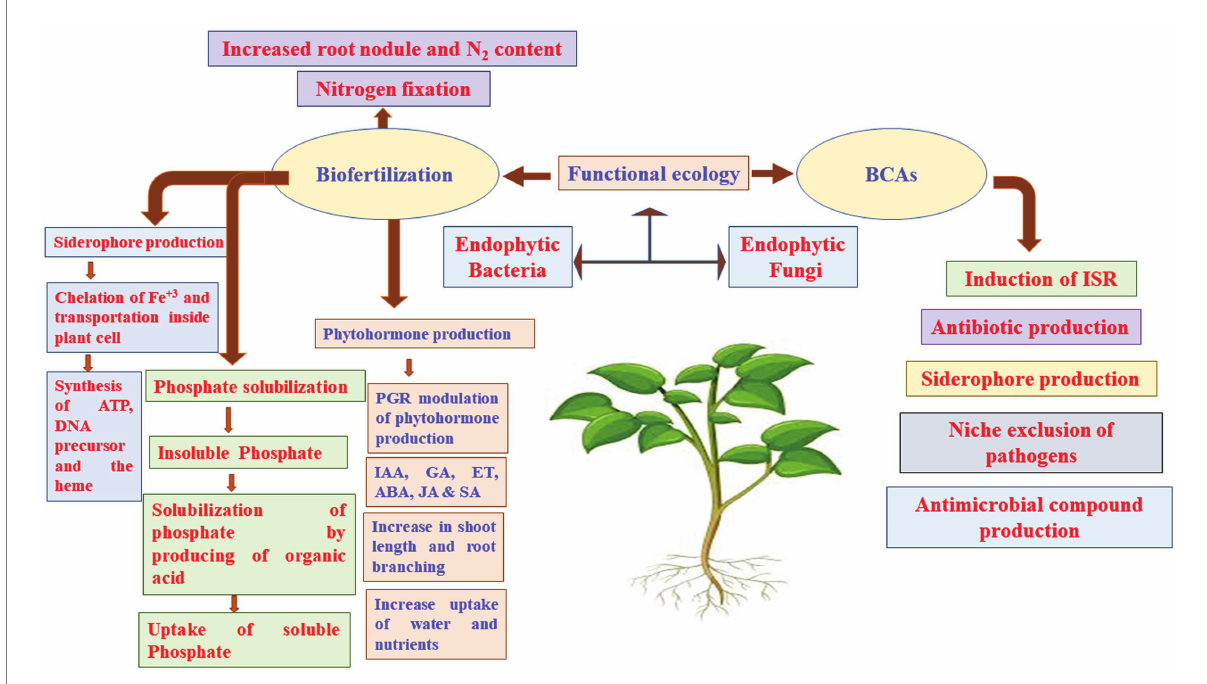
FIGURE 5 Dynamic microbial ecologies. ABA, abscisic acid; BCA, biocontrol agents; ET, ethylene; GA, gibberellic acid; IAA, indole acetic acid; ISR, induced systemic resistance; JA, jasmonic acid; PGR, plant growth regulators; SA, salicylic